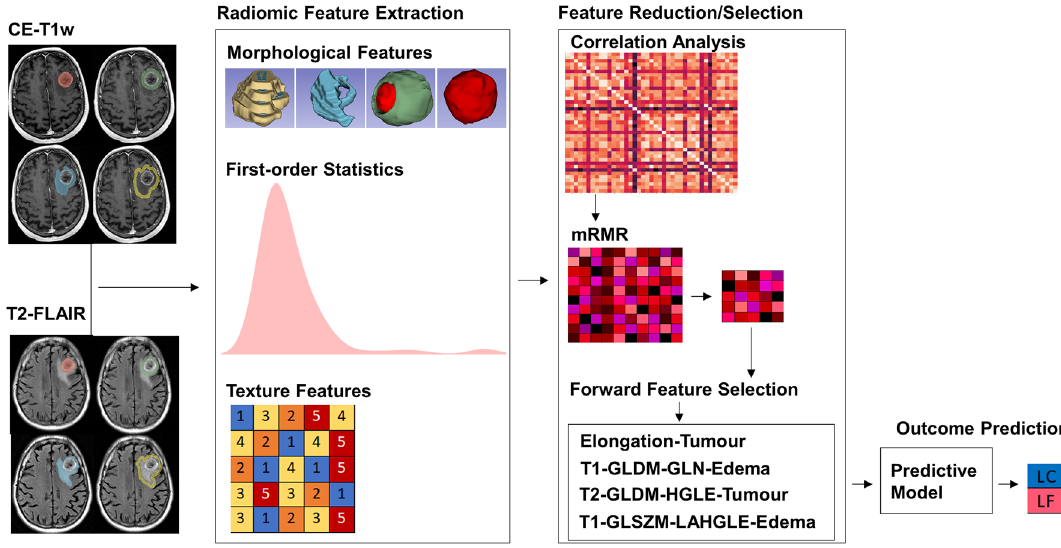
Figure 2. Scheme of the MRI radiomic framework for SRT outcome